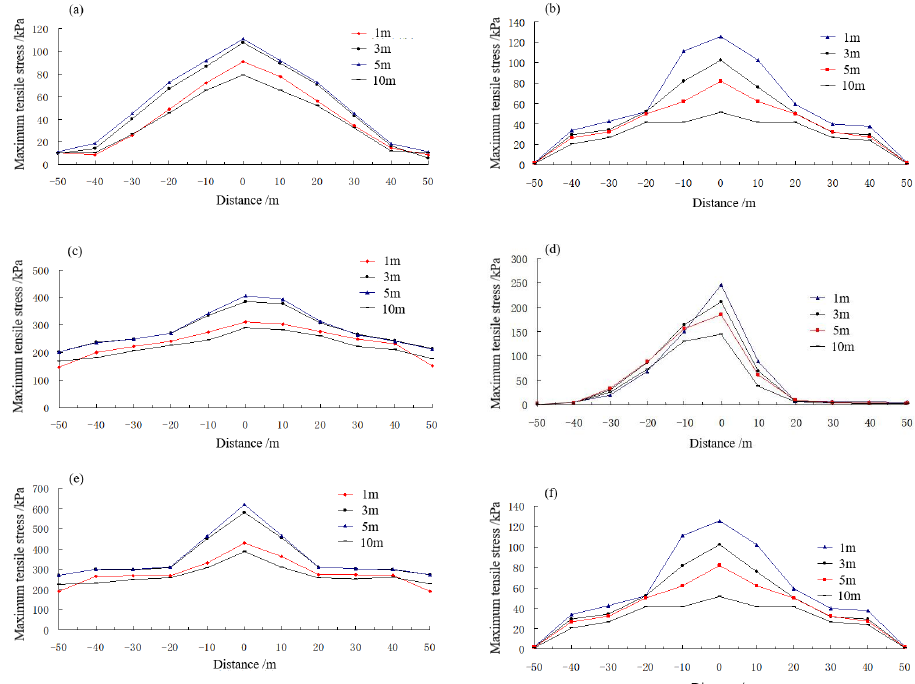
Figure 10. The maximum tensile stress, σ 1; distribution of secondary lining: ( a ) vault of upper tunnel,